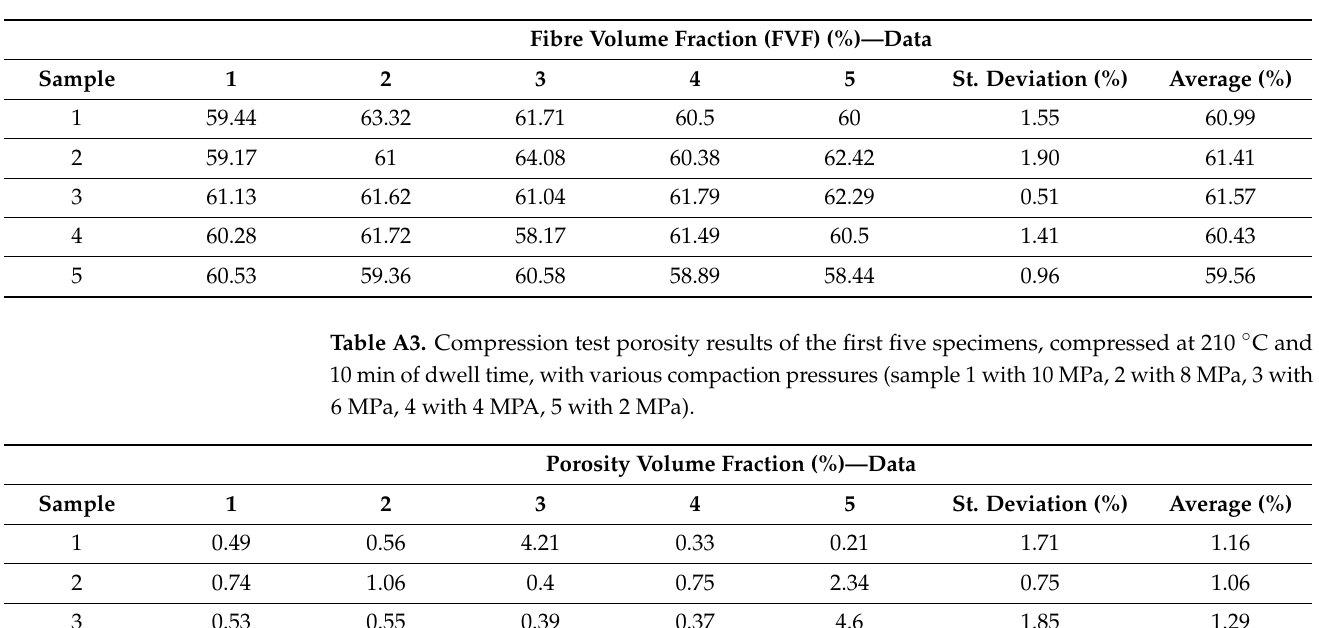
Table A2. Compression test FVF results of the first five specimens, compressed at 210 °C and 10 min of dwell time, with various compaction pressures (sample 1 with 10 MPa, 2 with 8 MPa, 3 with 6 MPa, 4 with 4 MPA, 5 with 2 MPa).